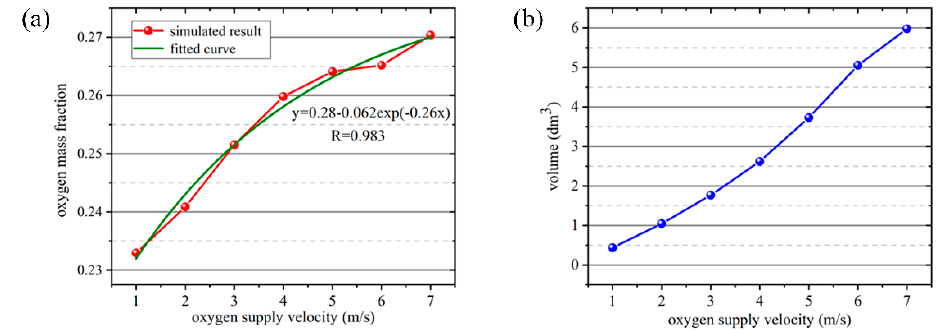
Figure 9. ( a ) Fitted curve of oxygen mass fraction of the air inhaled by human at di ff erent oxygen-supply velocities. ( b ) Volumetric distribution of regions with oxygen mass fraction up to 24.35% at di ff erent oxygen-supply velocities.